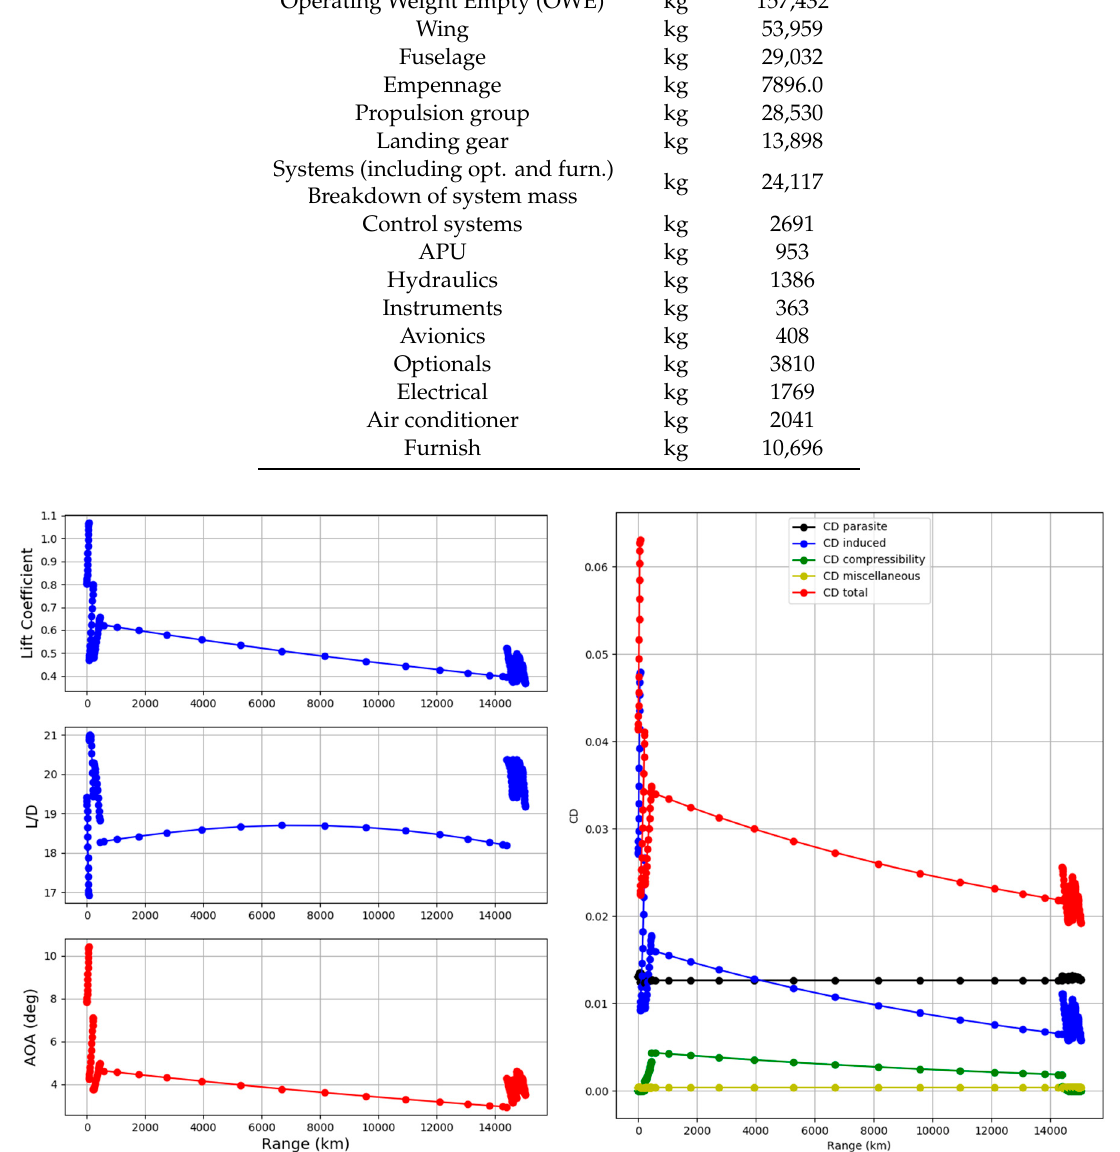
Figure A1. Aerodynamic performance of B777.